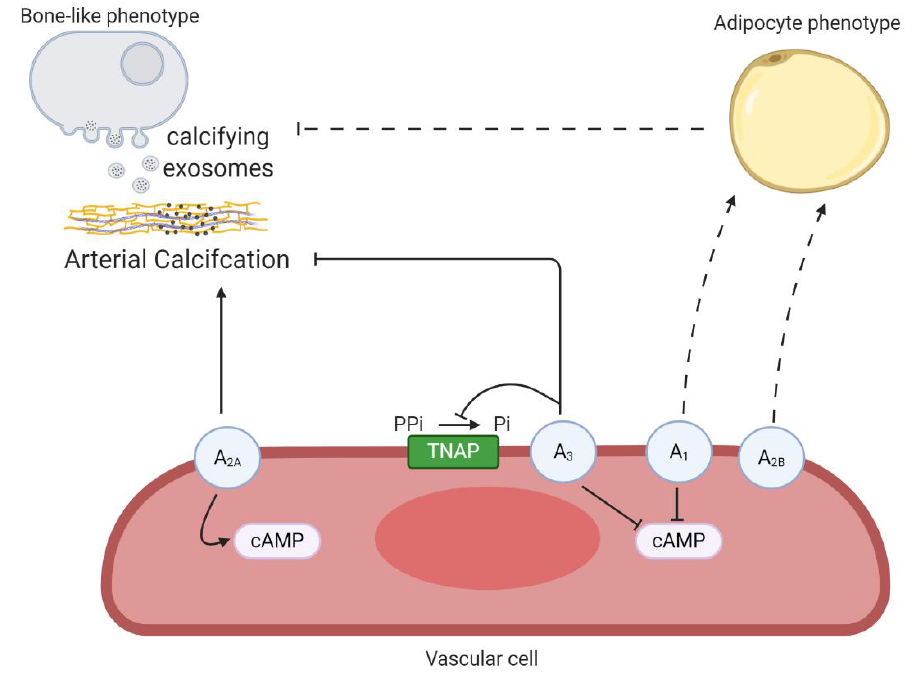
Figure 4. An overview the involvement of P1 receptors in arterial calcification. Activation of the A 2A receptor favors arterial calcification by stimulating intracellular cyclic adenosine monophosphate (cAMP) production. The A 3 receptor blocks arterial calcification through decreasing tissue non- specific alkaline phosphatase (TNAP) activity and cAMP production. Both A 1 and A 2B receptors might favor a phenotypic switch of vascular cells into an adipocyte phenotype and by this prevent the transdifferentiation towards a bone-like phenotype, thus halting the arterial calcification process. Dashed lines represent relevant findings in other cell-types, not yet shown in vascular cells. The term vascular cell covers vascular smooth muscle cells and valve interstitial cells. Arterial media calcification is associated with arterial stiffening. A vicious cycle of arterial stiffness and arterial media calcification is described in which mechano-sensing plays an important role as VSMCs sense matrix stiffness, which in turn induces alterations in gene expression and thus, stimulates the phenotypic conversion of VSMCs [17]. Interestingly, activation of the P2Y 2 receptor has been associated with mechano-sensing in osteoblasts and chondrocytes [86–88]. During mechanical loading, stimulating the bending of bones and matrix deformation, a pressure gradient is built up in the interstitial fluid. Osteocytes are connected by narrow channels, canaliculi, through which the interstitial fluid has to be squeezed, creating a high wall shear stress within these channels [89]. This fluid shear stress triggers an extracellular calcium influx, by activation of mechanosensitive and voltage-sensitive calcium channels, leading to extracellular release of ATP and UTP from vesicles stored in the osteoblast. Both nucleotides activate the P2Y 2 receptor mediated RhoA/Rock pathway resulting in the formation of actin stress fibers and thus modifying osteoblast stiffness [86]. Similarly to this, vascular wall shear stress initiates the release of ATP by endothelial cells stimulating the P2Y 2 receptor which is followed by the activation of endothelial nitric oxide synthase (eNOS) [90]. Additionally, another study indicated that P2Y 1 , P2Y 2 and potentially P2Y 4 receptors activate phospholipase C leading to the production of inositol trisphosphate (IP3) and diacylglycerol, favoring protein kinase C activation and the release of intracellular calcium stores, ultimately leading to the phosphorylation/activation of eNOS in endothelial cells [91]. NO induces vasodilatation through relaxation of the VSMCs. Several studies have shown that NO limits the development of